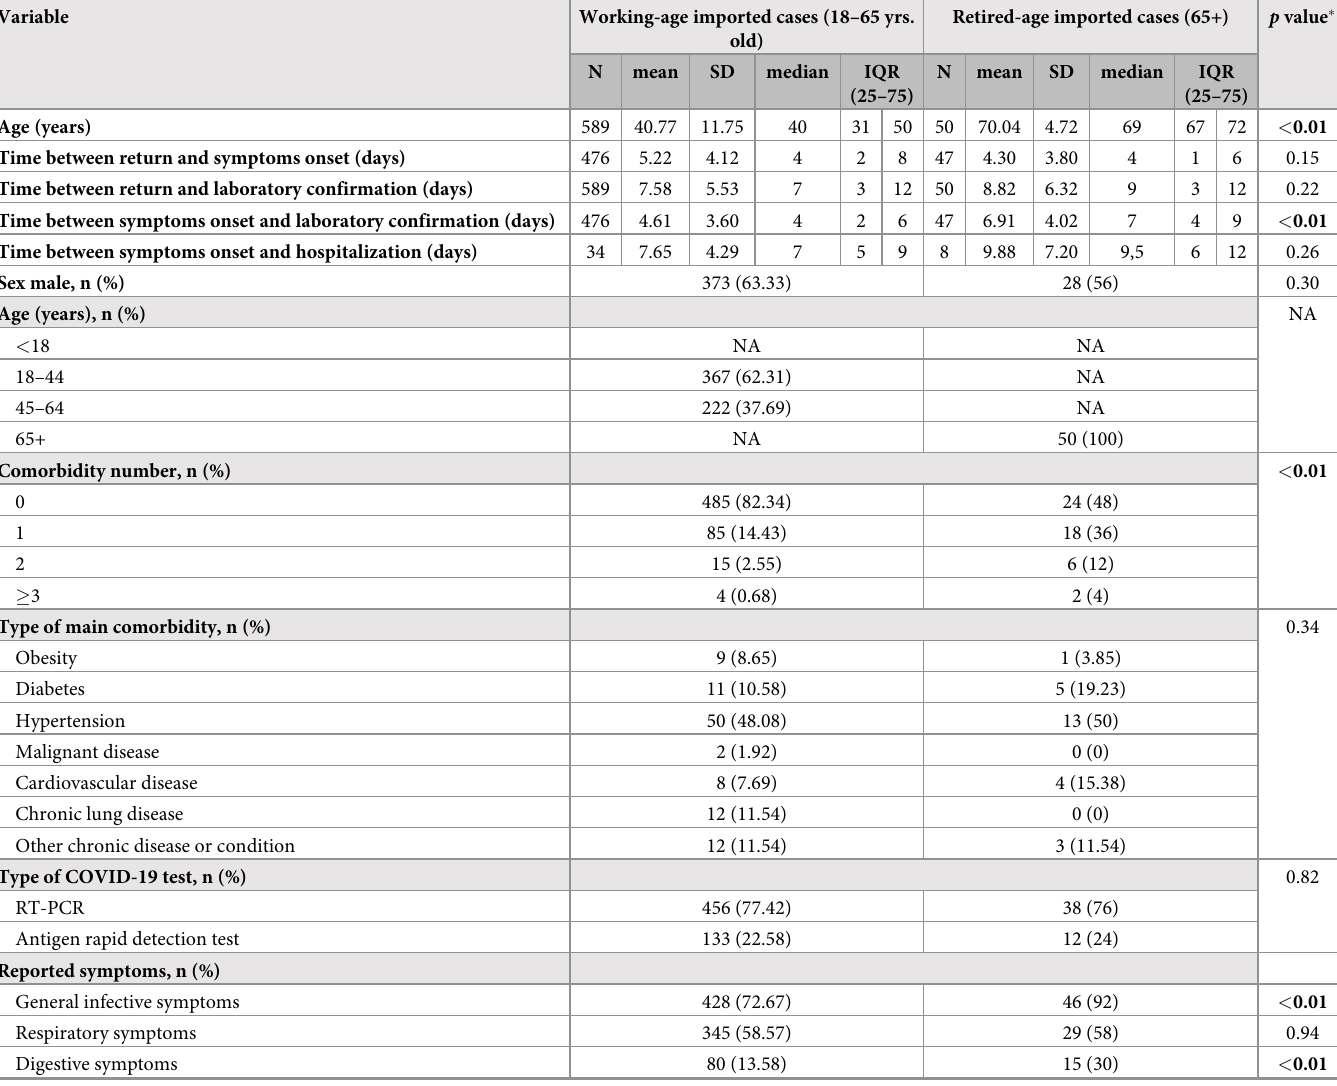
Table 2. Comparison of sociodemographic and epidemiological characteristics of COVID-19 travel-associated cases between working and retired-age patients in Vojvodina, Serbia, in the period March 6—December 31, 2020.